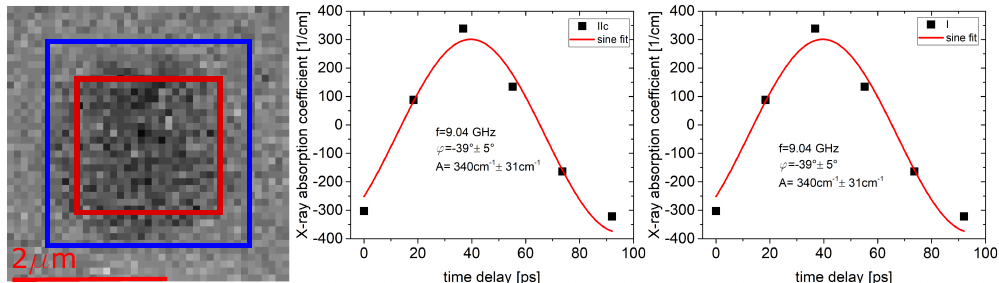
Figure 3. By averaging over the sample in the six different phases for evaluation method IIc (left side) and I (right side) from Figure 2, one can obtain the curves shown. Both were fitted with a sine function due to the sinusoidal behavior of the exciting microwave. The frequency of this sinusoidal was given by the microwave frequency applied to the system which in this case was